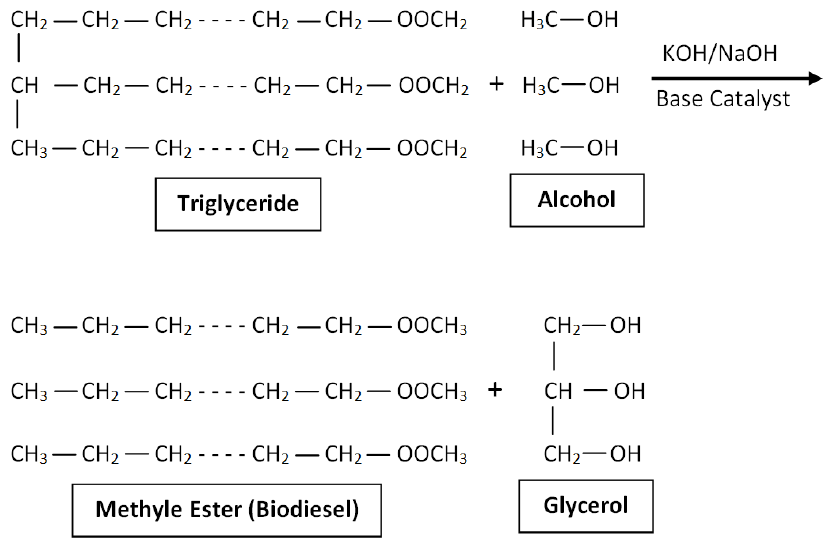
Figure 2. Transeterification reaction [60].